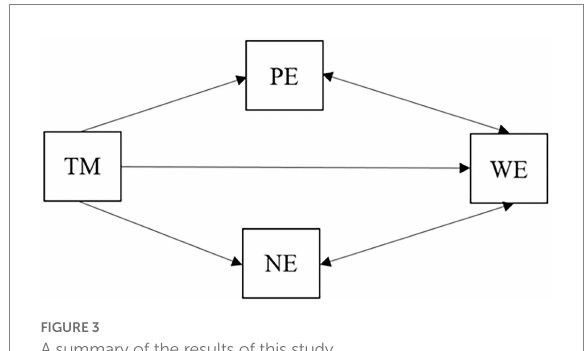
FIGURE 3 A summary of the results of this